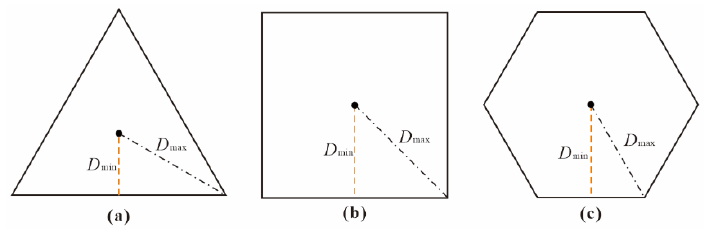
Figure 2. Grid center distance analysis. ( a ) regular triangle; ( b ) regular hexagonal; ( c ) regular hexagonal.